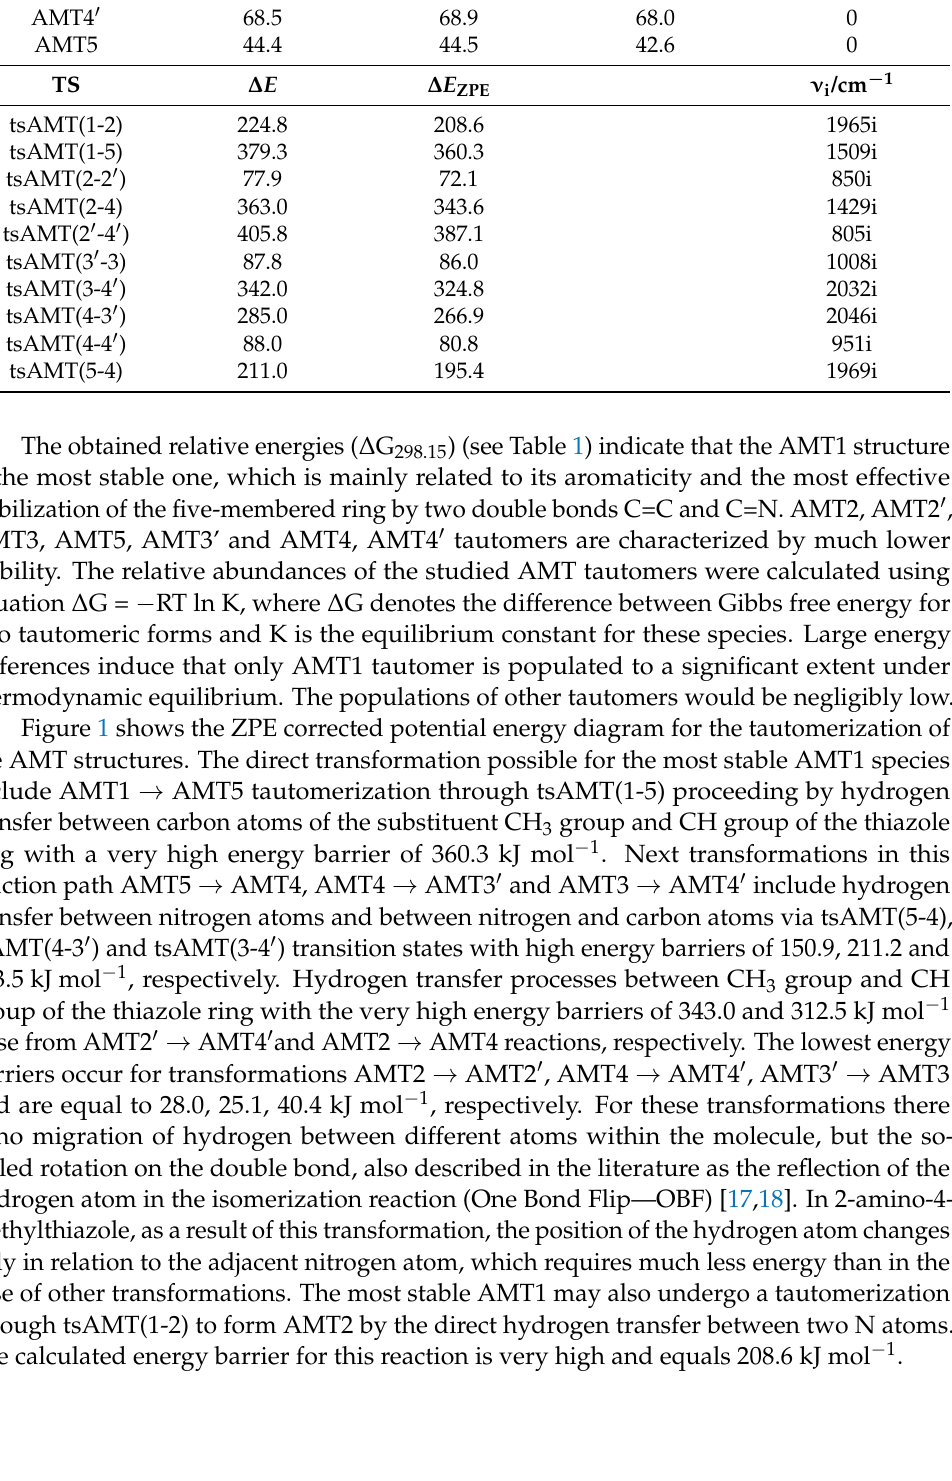
Table 1. Relative energies ( ∆ E ), relative zero-point corrected energies ( ∆ E ZPE ), relative Gibbs free energies ( ∆ G ) (in kJ mol − 1 ) and abundances at 298 K for 2-amino-4-methylthiazole tautomers and transition states calculated at the B3LYP/6-311++G(3df,3pd) level. Minima ∆ E ∆ E ZPE ∆ G 298.15 % 298 AMT1 0.0 0.0 AMT2 AMT2